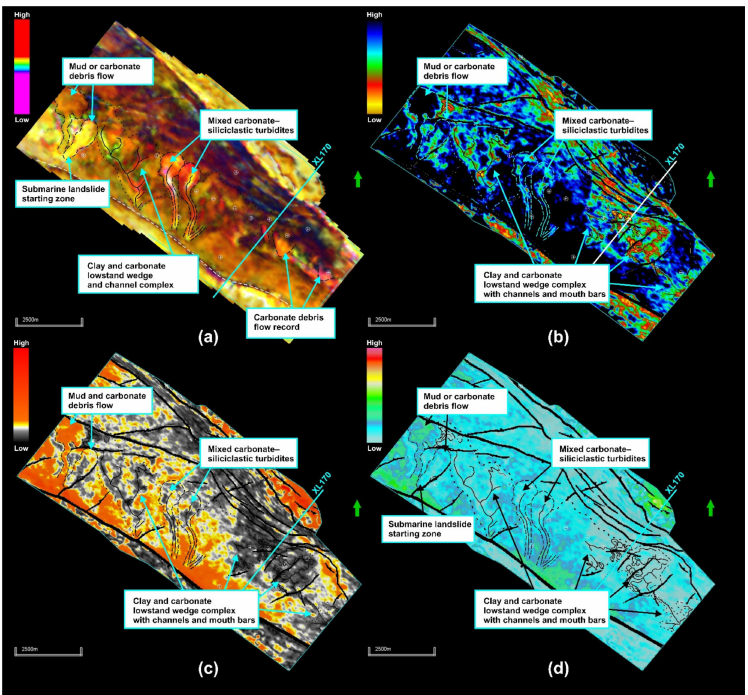
Figure 5. Maps presenting depositional architecture elements interpreted with the results of spectral decomposition and seismic attributes shown at K3_int surface: ( a ) spectral decomposition based on FFT algorithm; ( b ) sweetness; ( c ) RMS amplitude; and ( d )